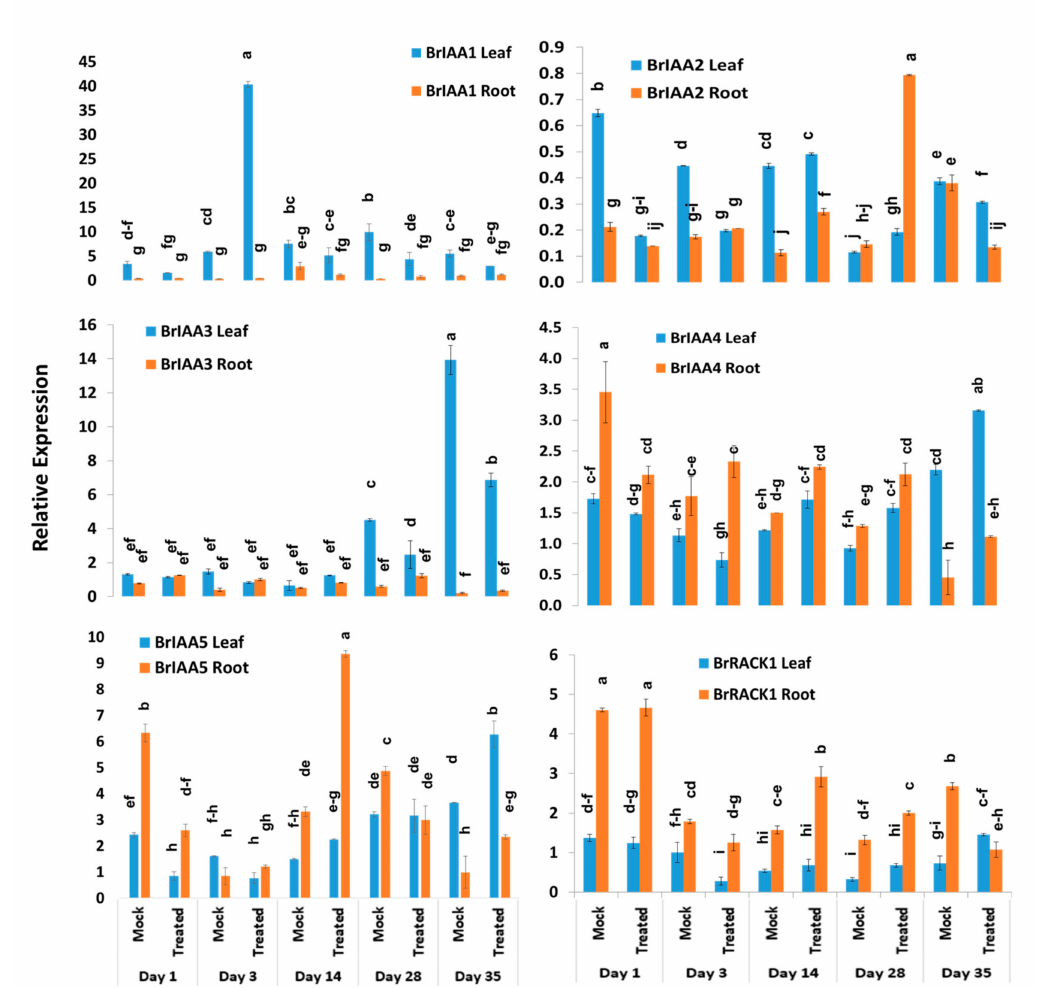
Figure 5. Variation in relative expression levels of auxin-related genes BrIAA and BrRACK1 genes in leaf androotsamplesunderdi ff erenttreatment × timepointcombinations: Datarepresentrelativeexpression levels of three di ff erent treatment types—sample type (leaf vs. root), treatment (Seosan-inoculated vs. mock-treated), and time-points. Vertical bars represent standard deviation. Each data point estimates the average of three independent biological replicates. Data bars separated by di ff erent letters indicate 5% statistical significance level according to Tukey’s pairwise comparisons. Expression of genes in leaf tissues of control (nontreated) plants on day 0 were set to